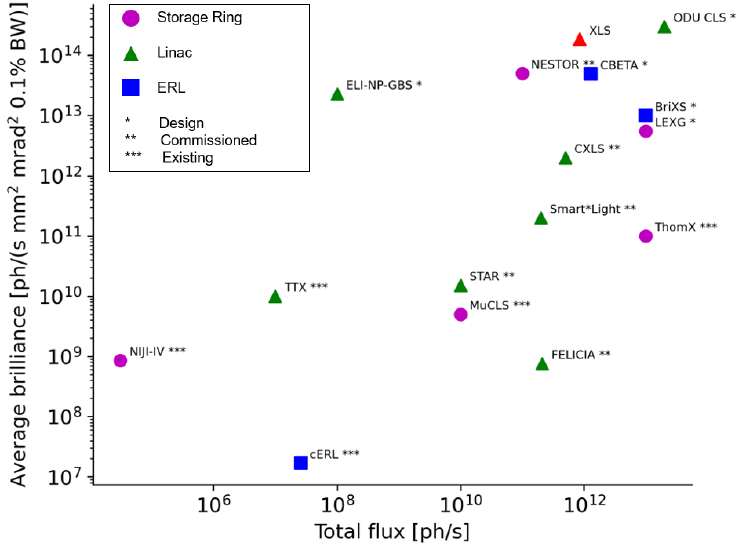
Figure 1. Landscape of ICS sources. Known ICS sources were sampled based on their total flux and average brilliance. Values for the CompactLight-based source were also included, in